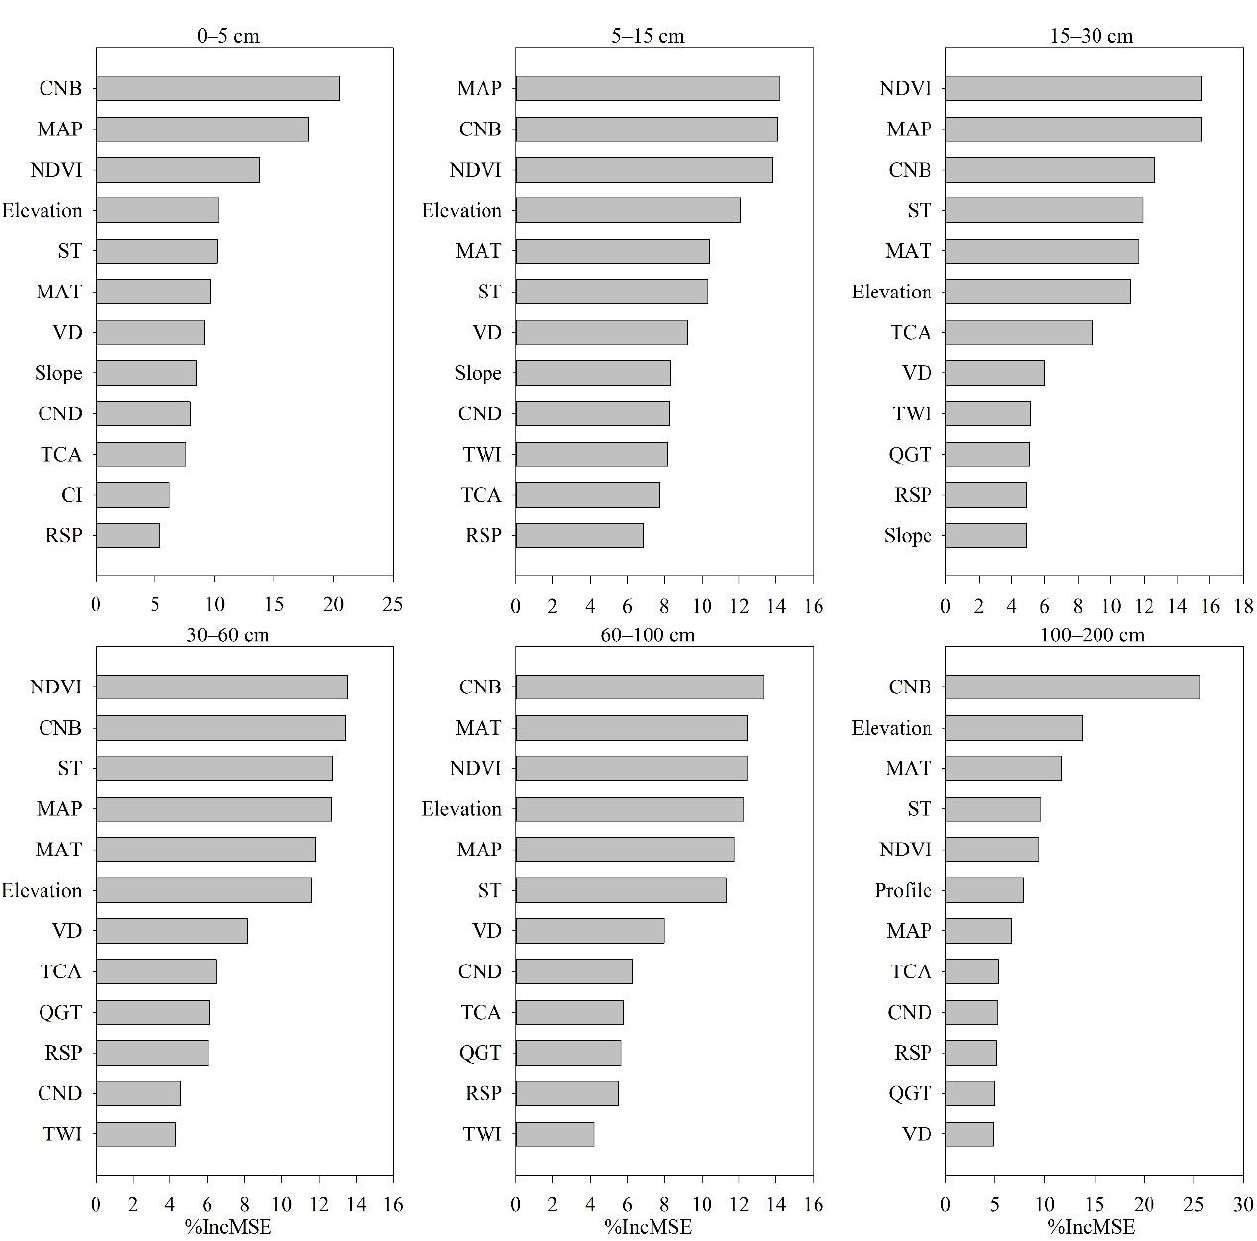
Figure 5. Relative importance (%IncMSE) of the covariates for clay predictions.